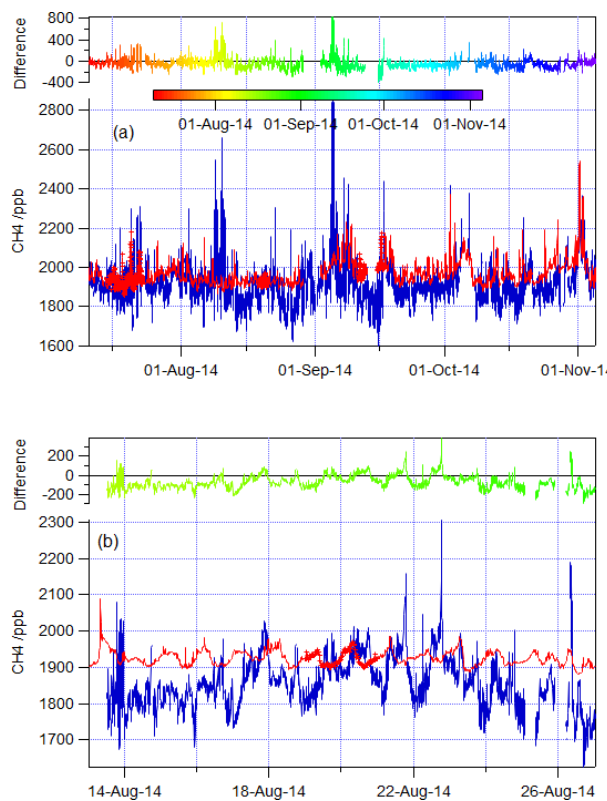
Figure 11. Open-path (blue), in situ (red) and difference (OP – in situ, coloured by time) measurements of CH 4 for the whole mea- surement period. The uncalibrated OP data have been reduced by a factor of 1.030 ( ∼ 60ppb) to fit the in situ data for wind speeds > 6ms − 1 (see text). (a) whole measurement period. (b) expanded period.